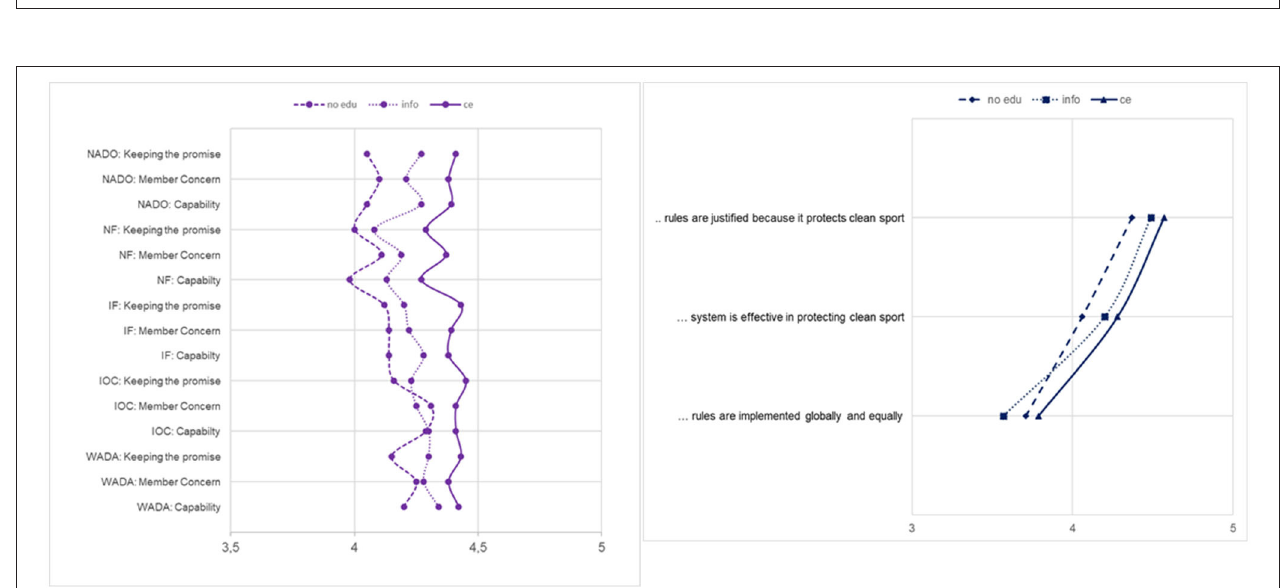
FIGURE 7 | Differences in perceived trust and legitimacy according to the level of education received. Trust: Minimum–Maximum: 1–5; → figure is scaled to provide more detailed information; ce, comprehensive education. All changes were significant, except for “WADA: member concern” and “IOC: capability.” For details on p -values and post-hoc tests, refer to Supplementary Table 5 . Legitimacy: Minimum–Maximum: 1–5; → figure is scaled to provide more detailed information; ce, comprehensive education. All changes were significant, except for “rules are implemented equally and globally.” For details on p -values and post-hoc tests, refer to Supplementary Table 5 . NADO, National Anti-Doping Organization; NF, National Sport Federation; IF, International Sport Federation; IOC, The International Olympic Committee; WADA, World Anti-Doping Agency.